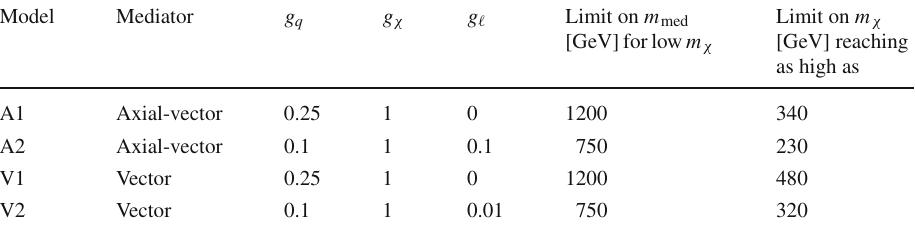
Table 8 Observed limits at 95% CL on the mediator mass and the DM particle mass for the four models considered. The mediators and couplings to quarks, to dark-matter particles and to leptons are specified for each model